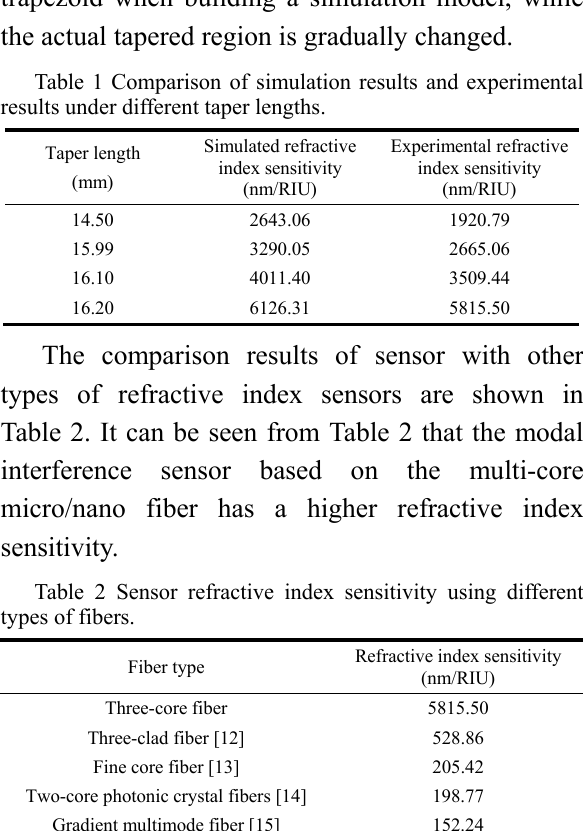
Fig. 10 Spectra and the relationship curves between wavelength and refractive index for different taper lengths: (a) spectrogram of the taper 14.5 mm, (b) relationship curve of the taper 14.5 mm, (c) spectrogram of the taper 15.99 mm, (d) relationship curve of the taper 15.99 mm, (e) spectrogram of the taper 16.1 mm, (f) relationship curve of the taper 16.1 mm, (g) spectrogram of the taper 16.2 mm, and (h) relationship curve of the taper 16.2 mm.